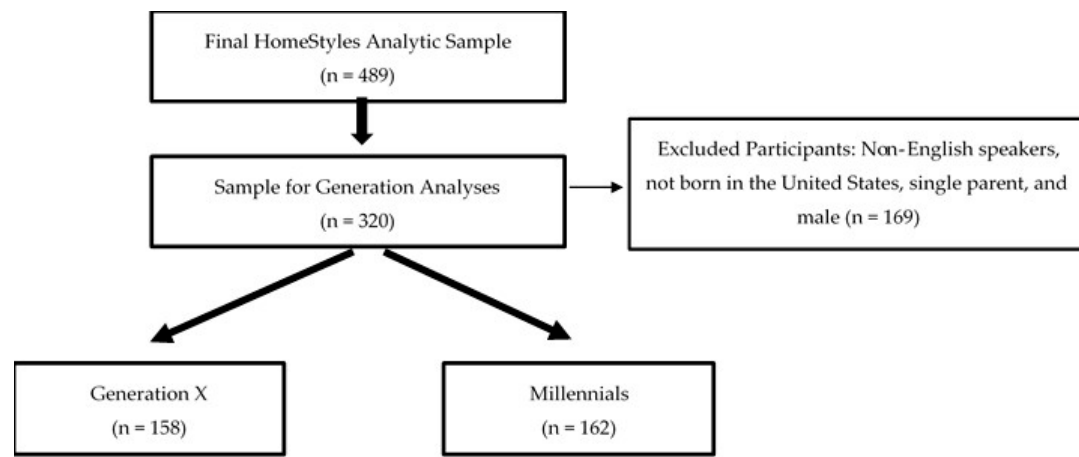
Figure 1. Analytic sample of the HomeStyles randomized control trial participants for analyses by generation.